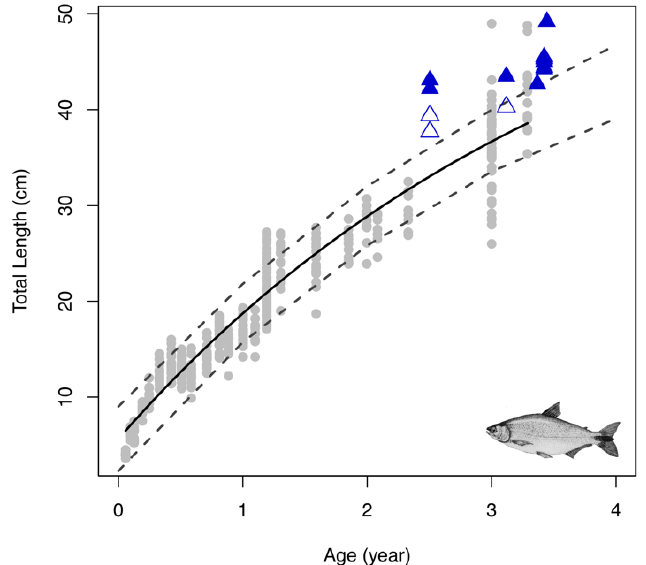
Figure 2. Comparison of the growth curve from Brycon orbignyanus control population and the age–length relationship of recaptured individuals (blue triangles; mature individuals are represented by color filled triangles). Confidence intervals of growth model are represented by dotted lines and grey points represent age–length individuals from the control population.